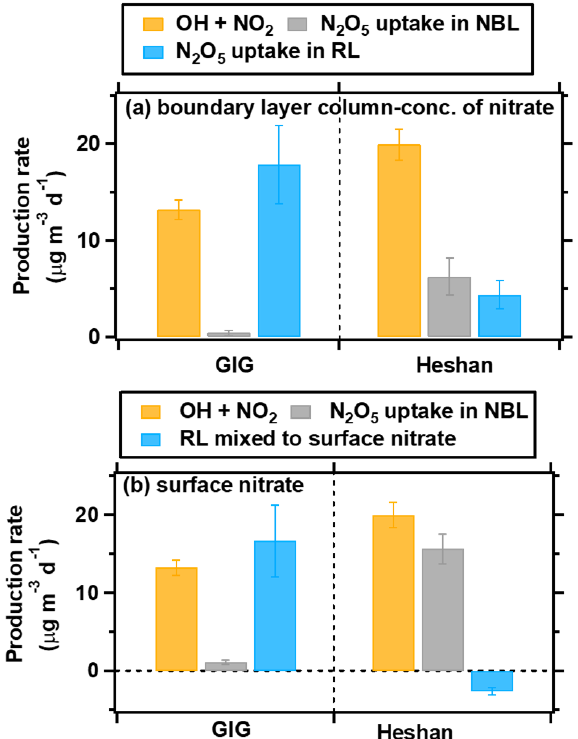
Figure 9. The daily-averaged contribution (a) to boundary layer column concentration and (b) to surface nitrate from three pathways (OH + NO 2 reaction, N 2 O 5 uptake in NBL, and N 2 O 5 uptake in RL or N 2 O 5 uptake from RL mixed process) at the GIG and Heshan sites. The error bars represent the standard deviations of the mean production